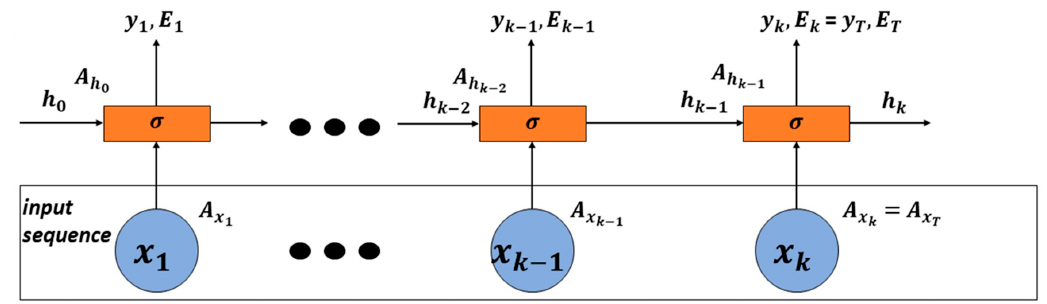
Figure 3. RNN sequence visualization.